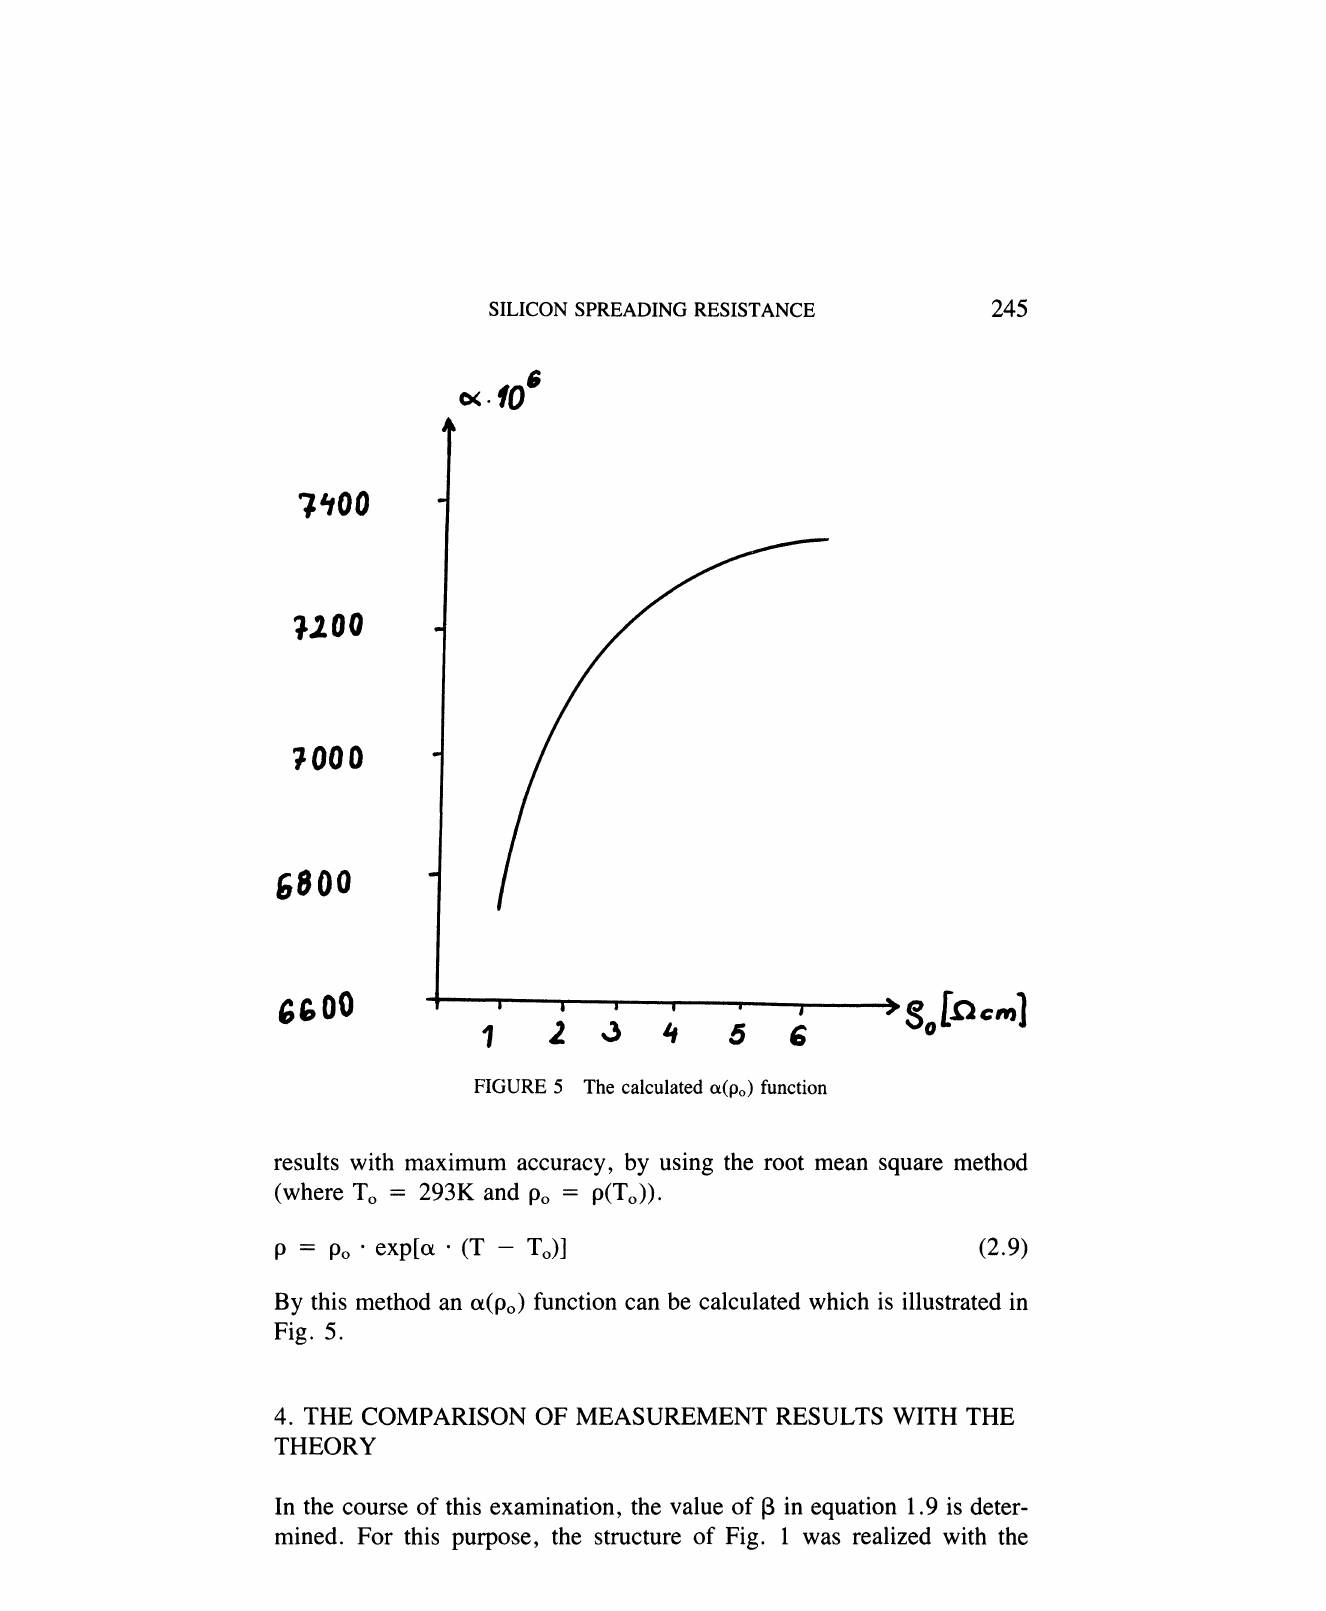
FIGURE 5 The calculated a(po)